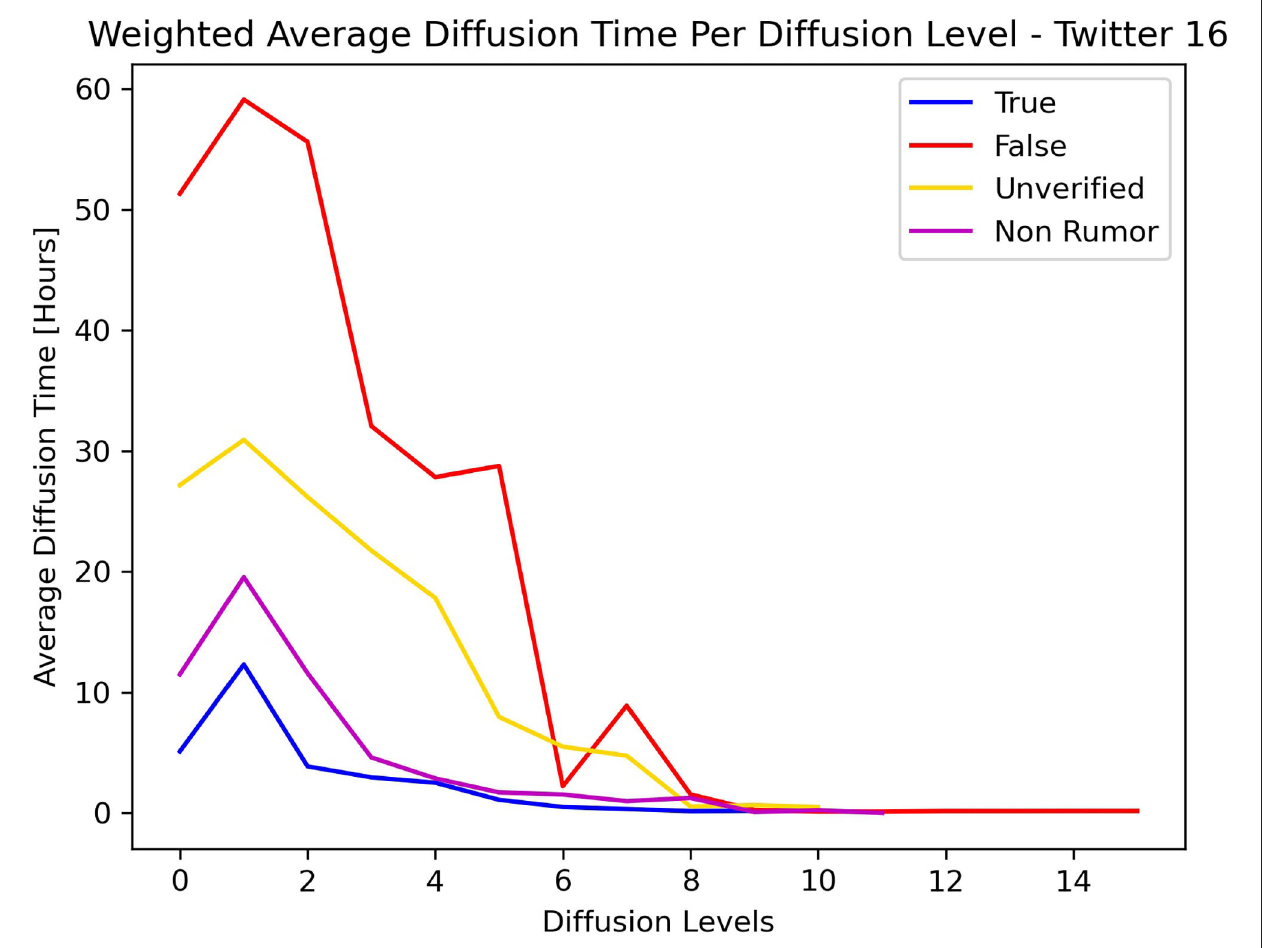
FIGURE 6 | Weighted average diffusion time per diffusion level—Twitter16.